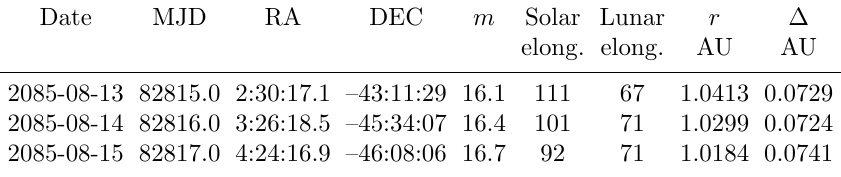
Table 4. Ephemerides of the closest approach of 2008 OS9 to Earth in